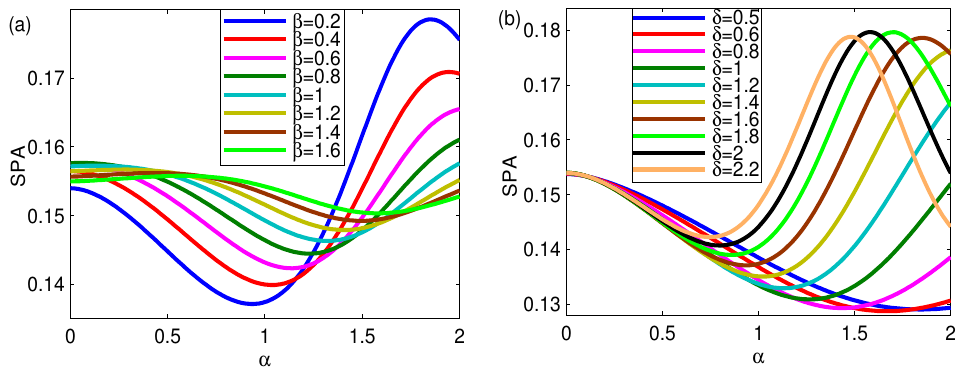
Figure 2. GSR behaviors of SPA( α ) in (36) for different ( a ) β and ( b ) δ . ( a ) ¯ γ = 0.1, δ = 1.6, τ = 0.2, ω 0 = 1, Ω = 2 µ = ν = 0.9; ( b ) ¯ γ = 0.1, β = 0.2, τ = 0.2, ω 0 = 1, Ω = 2, µ = ν = 0.9.